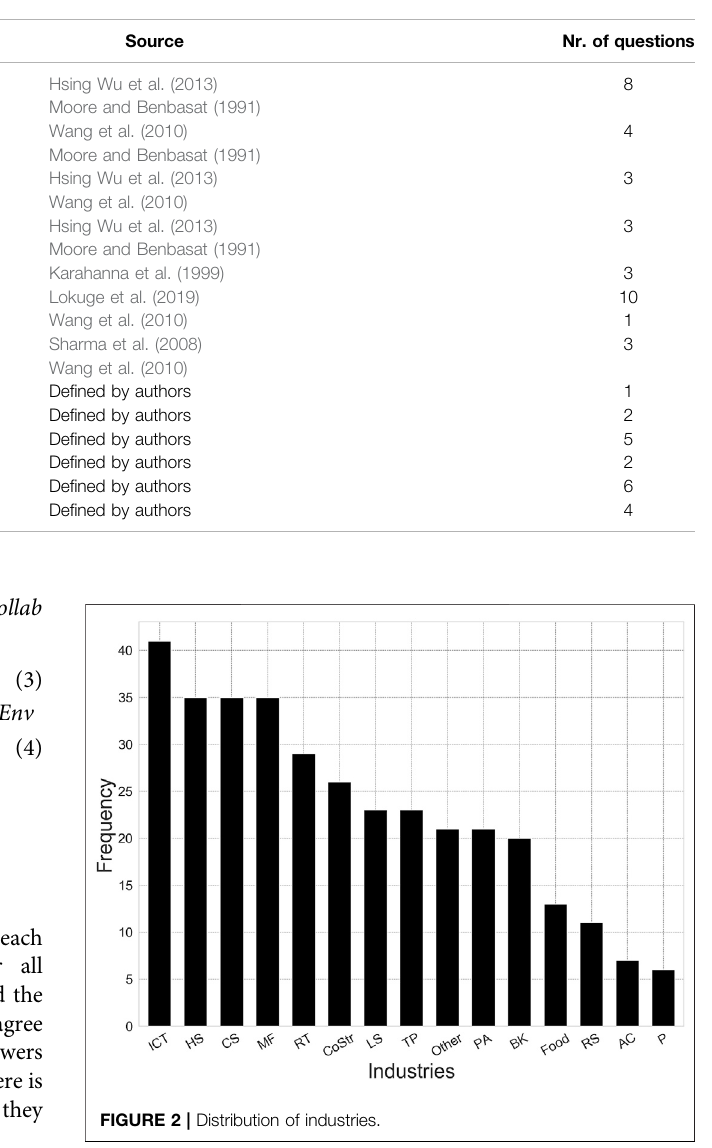
TABLE 2 | Sources for the survey questions.